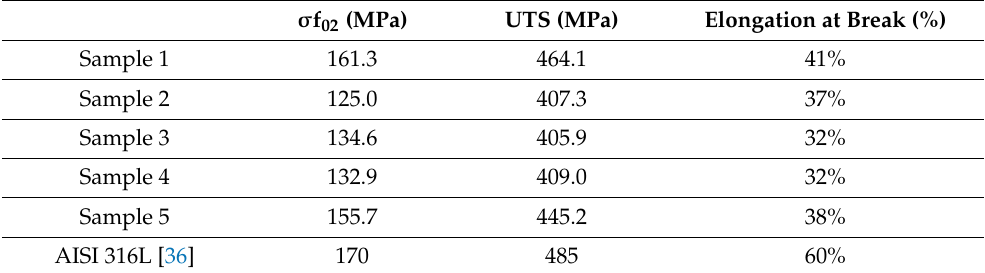
Table 2. Tensile properties of 316L AM samples.